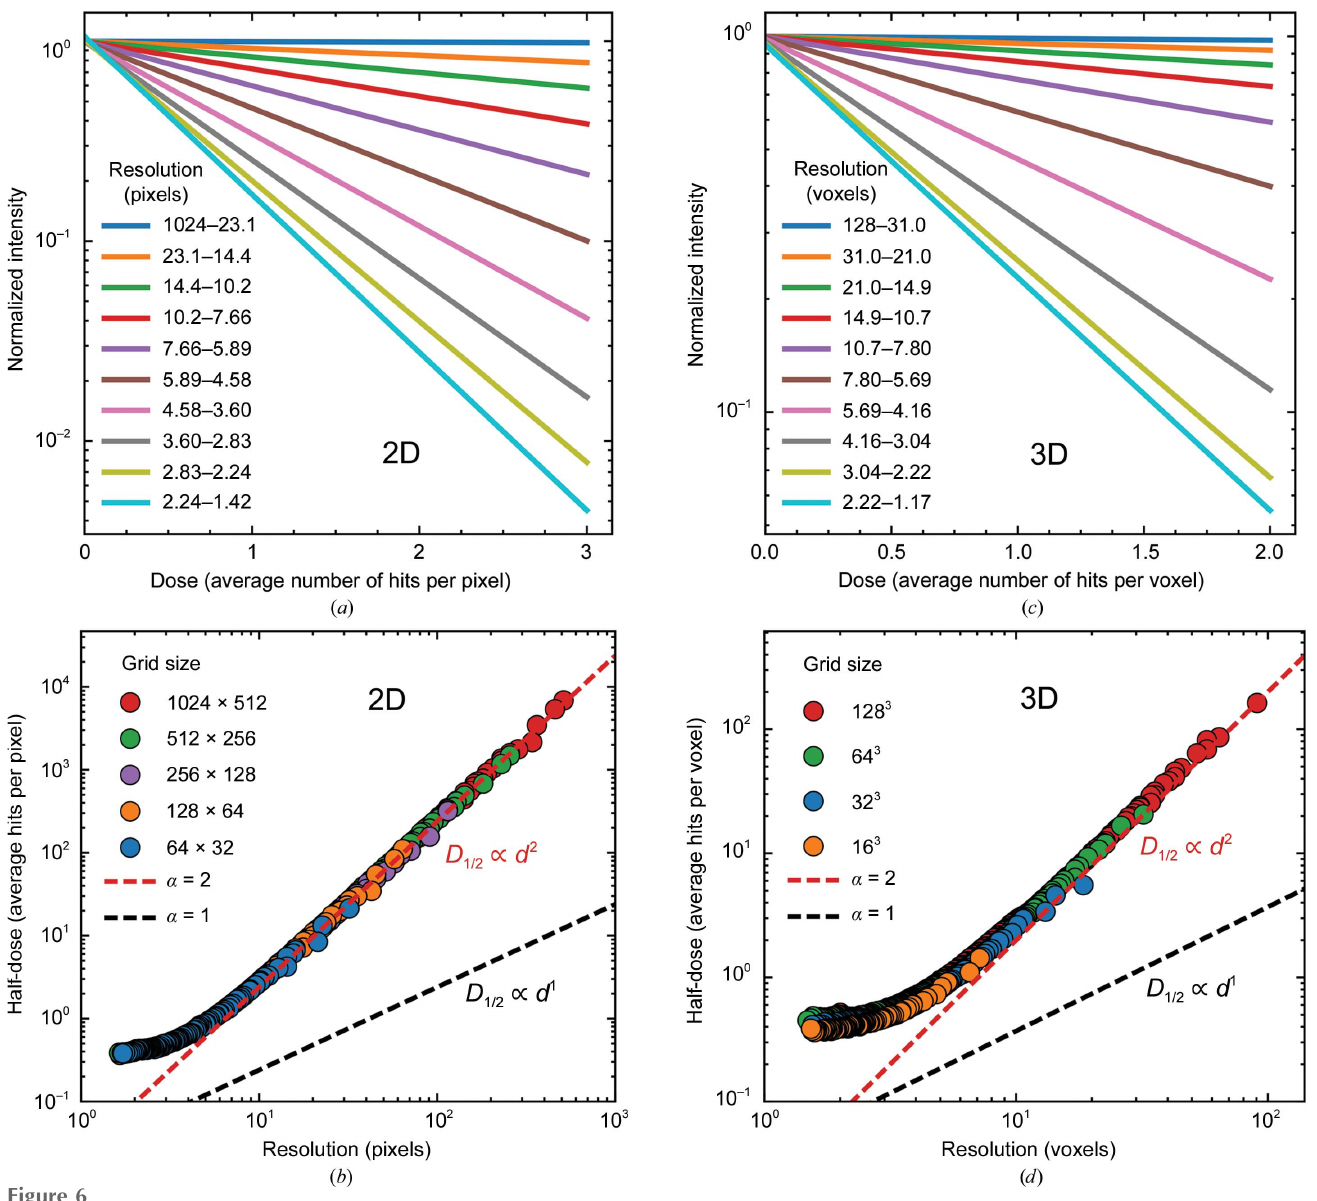
Figure 6 Simulation results for the random Gaussian blur model of radiation damage applied to ( a , b ) a two-dimensional crystal formed of pixelated images of a flea and ( c , d ) a three-dimensional crystal formed of a pixelated electron-density map for PDB entry 3e4h. In both two and three dimensions, the intensity within a given resolution shell decays exponentially with dose, and the half-dose varies with resolution d approximately as D 1/2 ( d ) / d (cid:2) , with (cid:2) approaching 2 at low resolutions (large numeric values of resolution). The best-fit values in the near-linear region are (cid:2) = 1.95 and (cid:2) = 1.86 in ( c ) and ( d ), respectively. Simulation details are given in the supporting